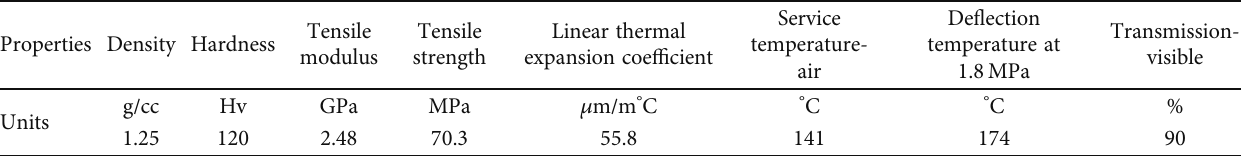
Table 1: Characteristics of polysulfones.